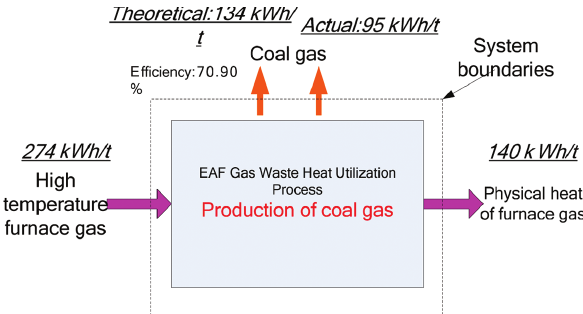
Figure 5: System boundaries of coal gas production for EAF gas waste heat